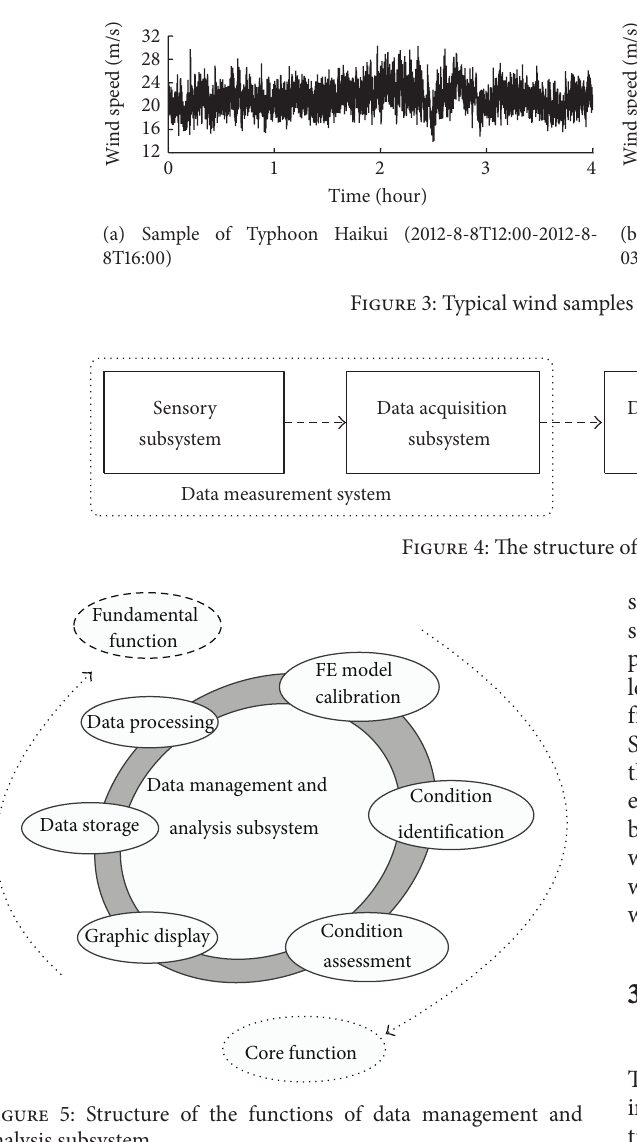
Figure 5: Structure of the functions of data management and analysis